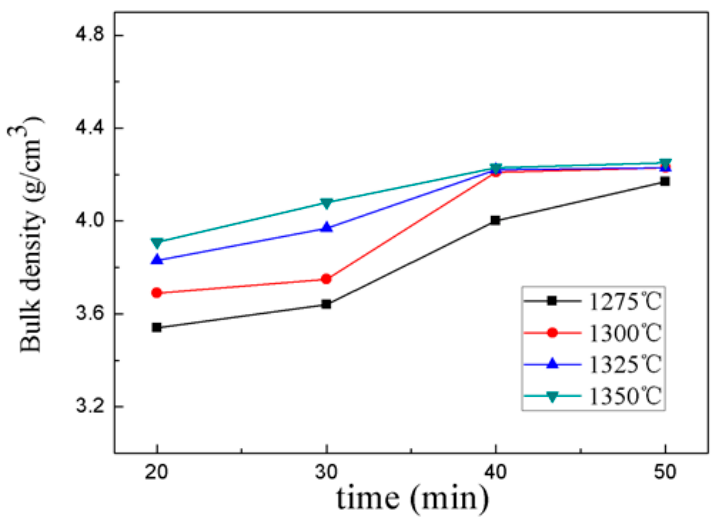
Figure 3. Bulk density of the 0.95CST–0.05BNT samples with different sintering temperatures and holding times by